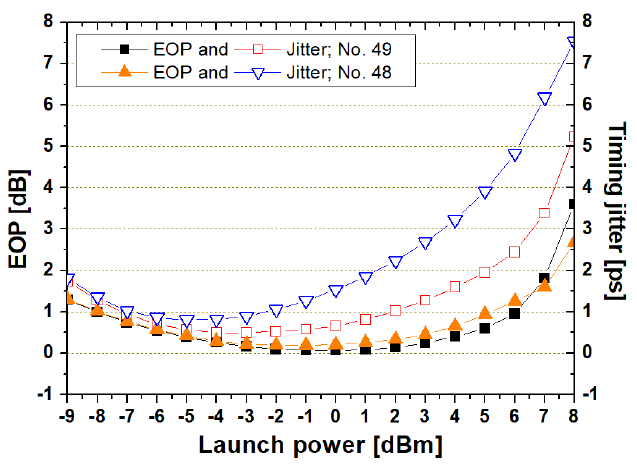
Figure 4. The EOP and timing jitter of pattern number 49 and 48 as a function of the launch power in case of random-inverse distribution.